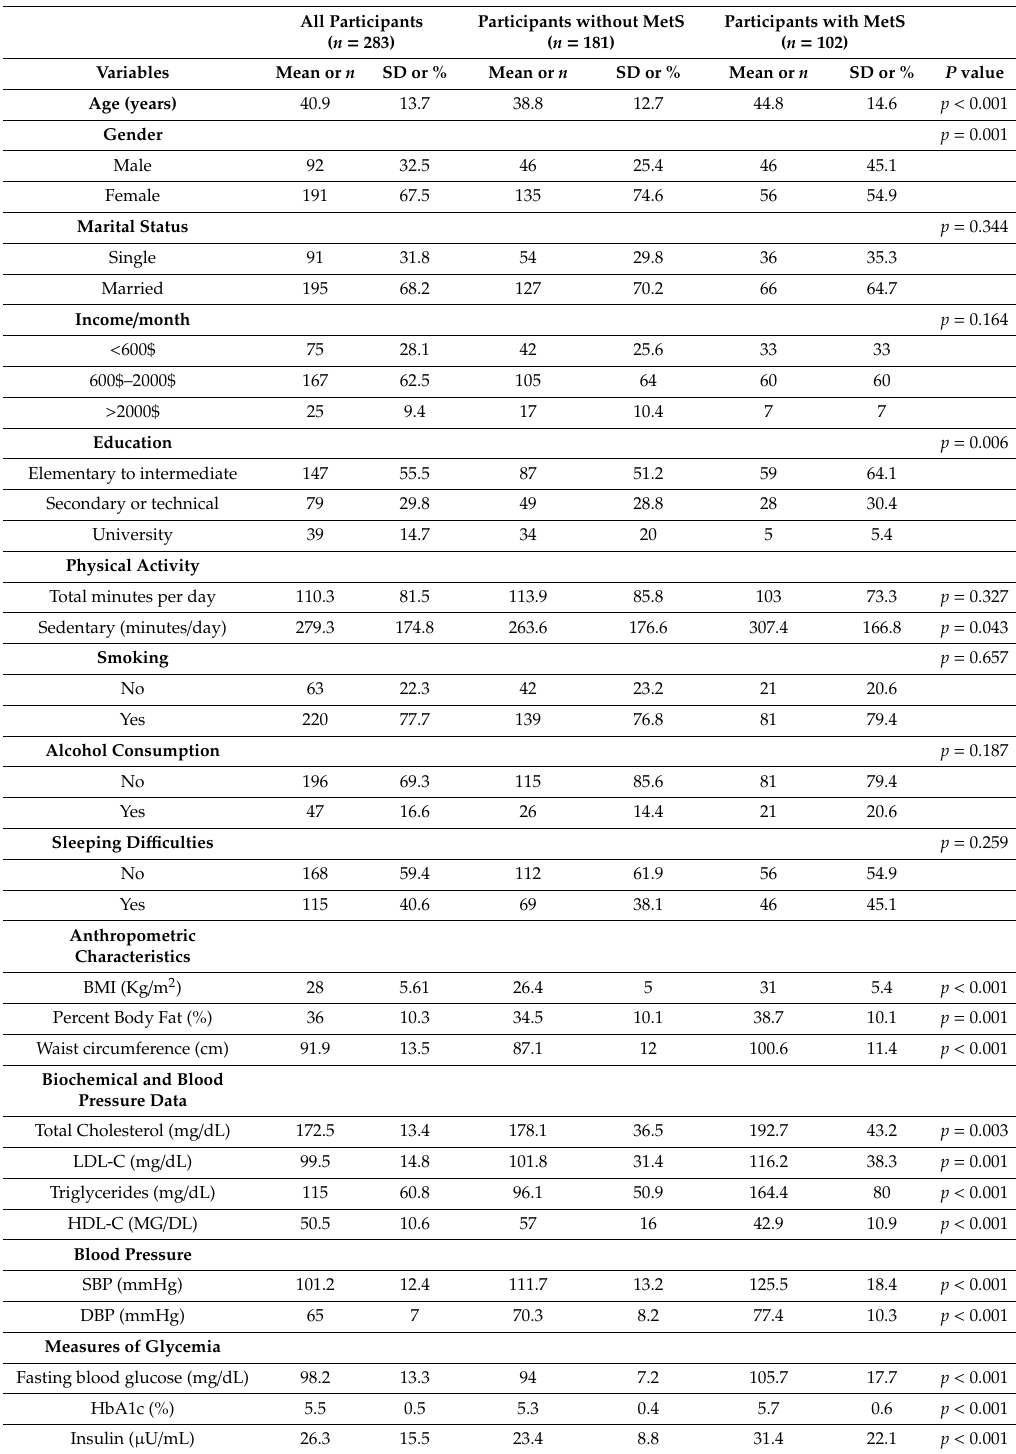
Table 1. Sociodemographic, lifestyle, and anthropometric characteristics and cardiometabolic risk factors in the study population ( n = 283) of Lebanese adults and by MetS